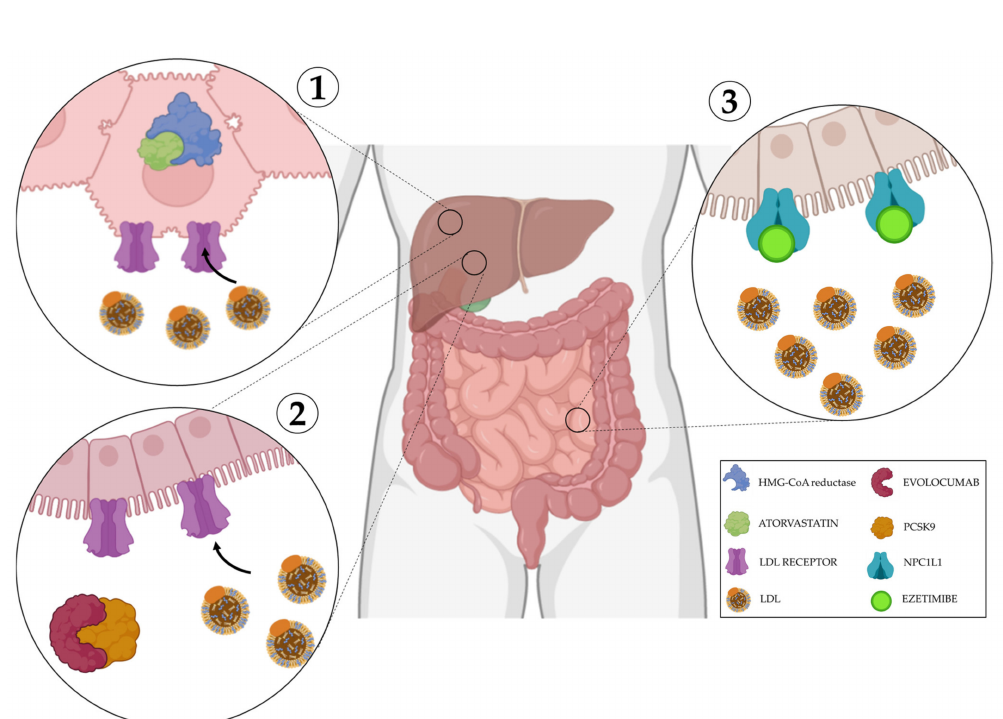
Figure 3. Mechanisms of action in cholesterol disruption. ( 1 ) Atorvastatin is a competitive inhibitor of HMG-CoA reductase, its inhibition decreases de novo cholesterol synthesis and increases expression of LDL receptors, removing LDL from the blood. ( 2 ) Evolocumab blocks PCSK9, a protein responsible for the breakdown of LDL receptors; this allows their overexpression facilitating LDL uptake from the blood. ( 3 ) Ezetimibe selectively inhibits the intestinal absorption of